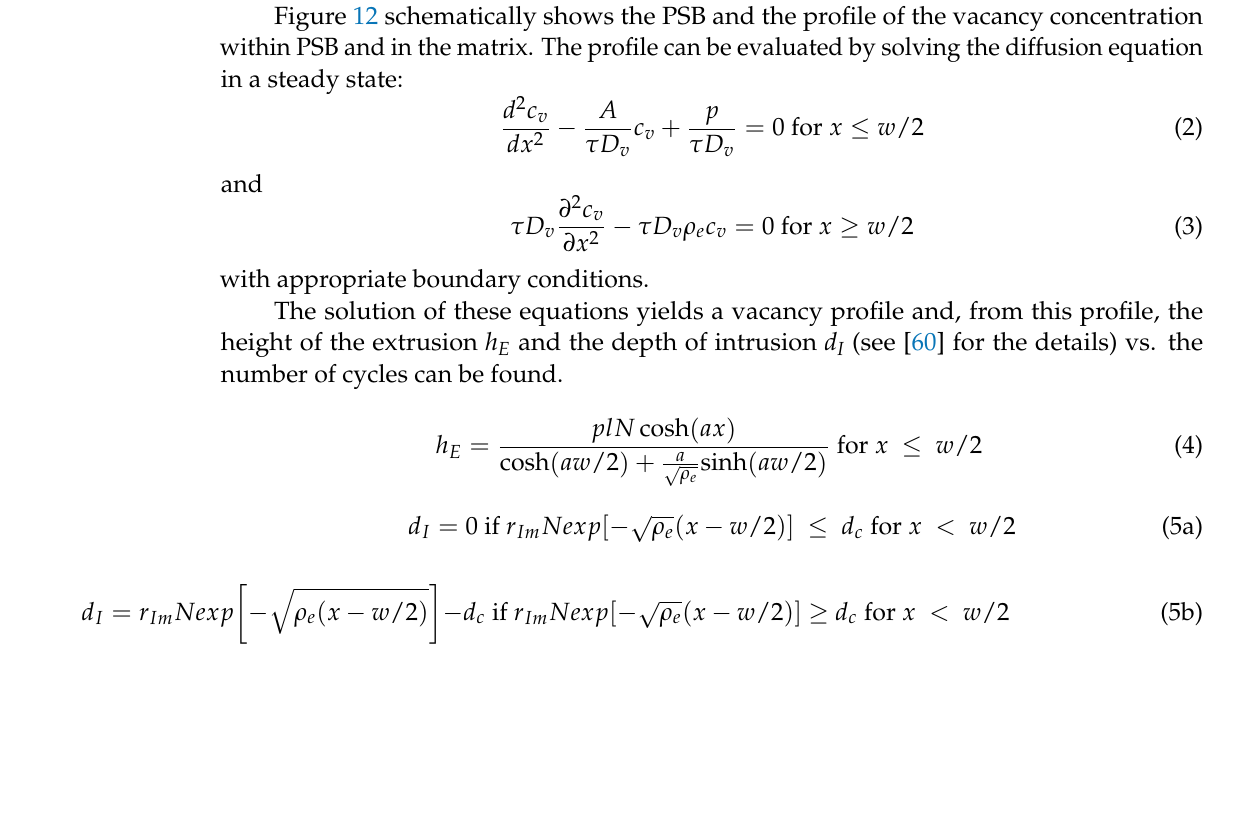
Figure 12. Schematic drawing of a PSB having the width w and the length l below the surface which is embedded in the matrix (artificially inclined 90 degrees to the surface). and the profile of vacancies migrating to the matrix and annihilated there at edge dislocations. The solution of these equations yields a vacancy profile and, from this profile, the height of the extrusion h E and the depth of intrusion d I (see [60] for the details) vs. the number of cycles can be found.